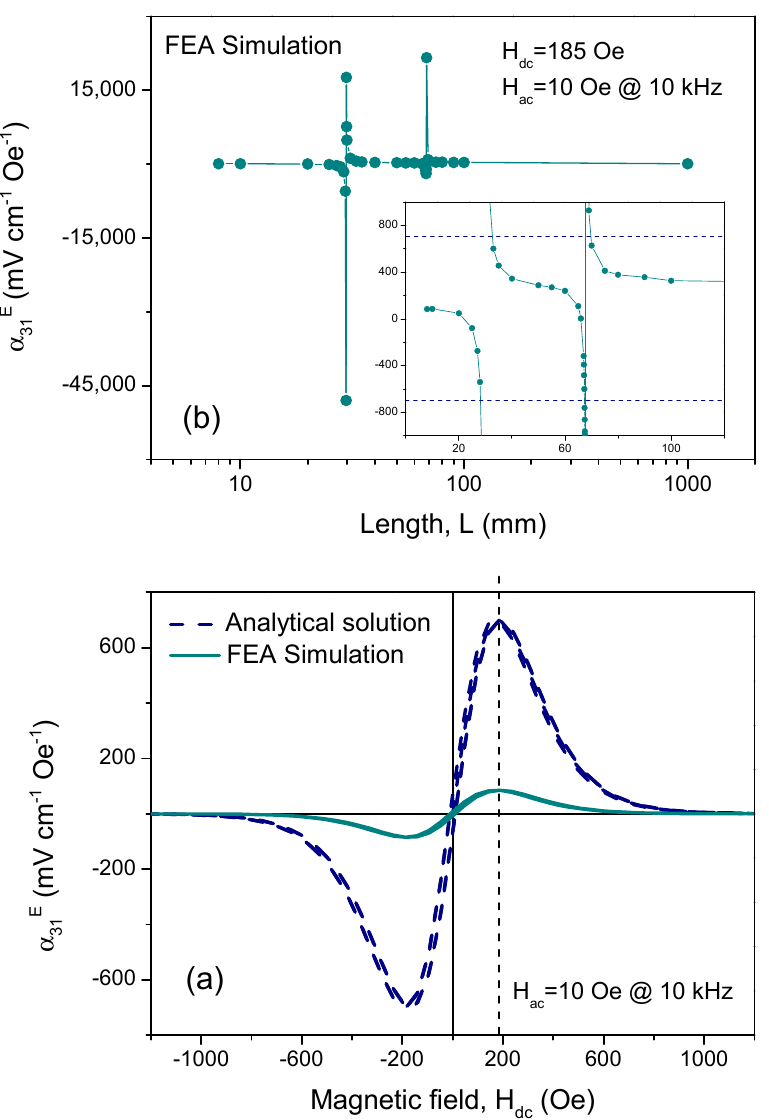
Figure 2. ( a ) Comparison of the magnetoelectric coefficient α 31 E obtained with the analytical solution of [12] for a bilayer with a piezoelectric fraction of 0.5, and those resulting from the simulation of a 1 mm/1 mm two-layer structure with 8 mm in-plane dimension; and ( b ) α 31 E coefficients from the simulation of 1 mm/1 mm two-layer structures with increasing in-plane dimension. Material coefficients corresponding to processing at 1000 °C have been used.